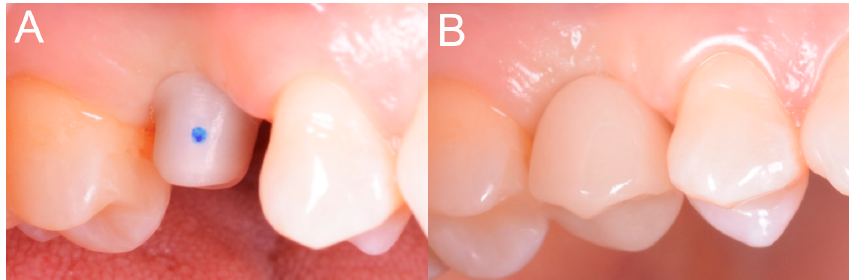
Figure 13. Delivery of the individual zirconia abutment ( A ) and the provisional PMMA crown ( B ). Occlusion was carefully checked and then polishing and staining/characterization was done.